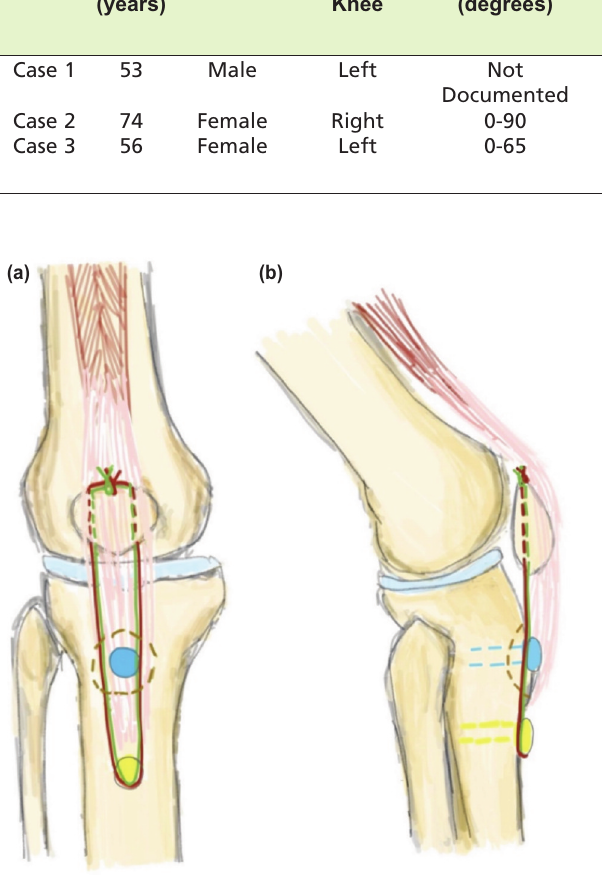
Post-operative picture after application of new Fig. 2: defunctioning technique.